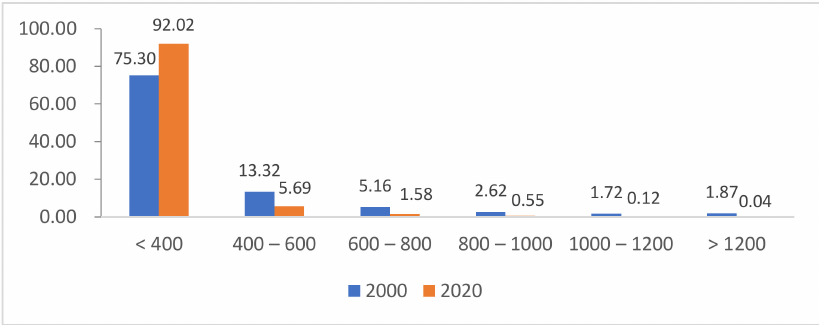
Figure 2. The count frequency of RCs at different distance from the nearest stops (unit: %).